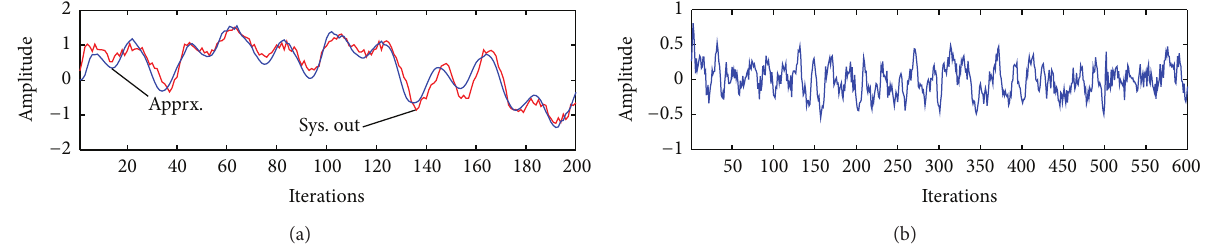
Figure 10: The simulation result with DLMS algorithm. (a) Process of identification. (b) Error of identification.